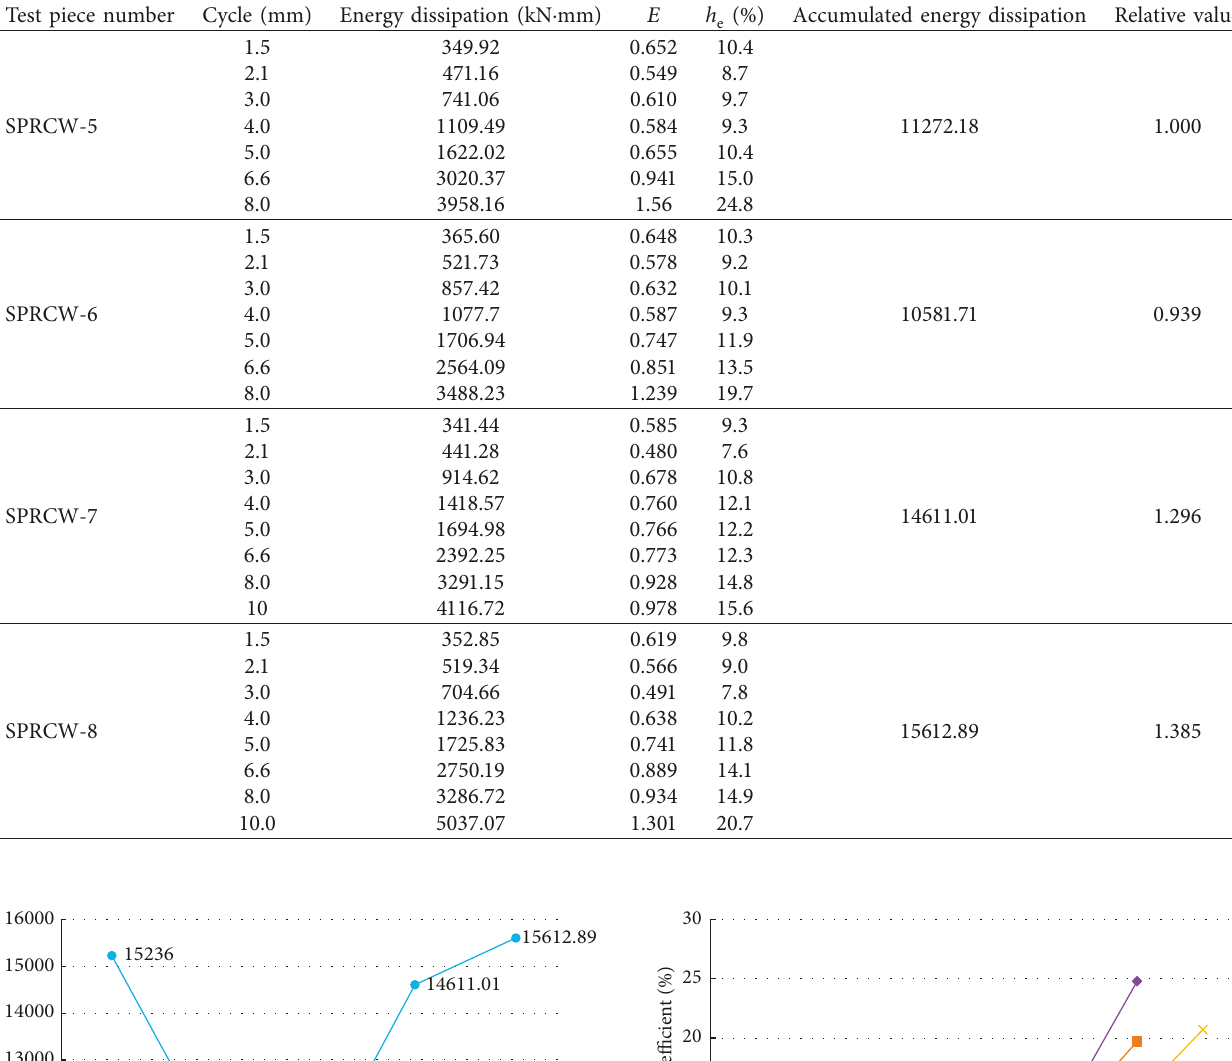
Table 5: Energy dissipation capacity of test pieces.